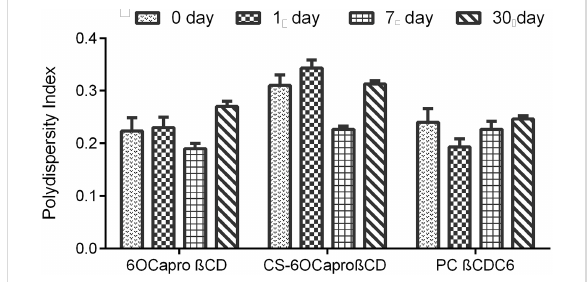
Figure 3: Time-dependent variation of the PDI value of PCX-loaded amphiphilic CD nanoparticles stored in aqueous dispersion form ( n = 3, ± SD).